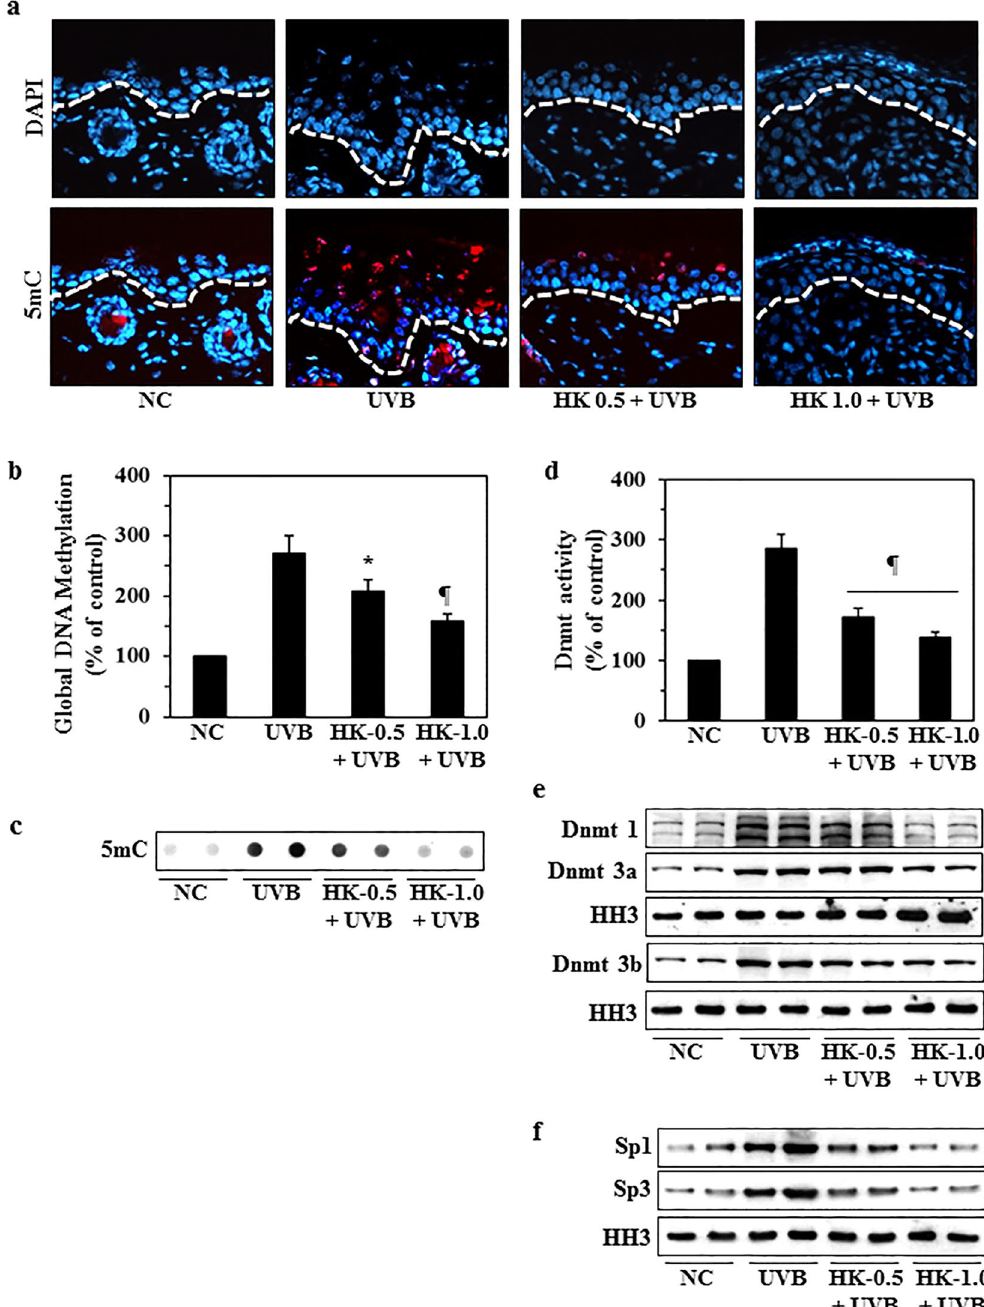
Figure 3. Topical application of honokiol inhibits UVB-induced DNA hypermethylation and DNA methyltransferase activity in UVB-irradiated mouse skin. Clipper-shaved mouse skin was exposed to UVB radiation (150 mJ/cm 2 ) for 4 consecutive days with and without topical application of honokiol. Mice were sacrificed 24 h after the last UVB exposure. Skin samples from each mouse were collected for analysis. ( a ) Representative micrographs of skin samples subjected to immunohistochemical detection of DNA methylation- positive (5mC + ) cells using a 5mC-specific antibody. 5mC + cells appear red. White line represent the boundary between epidermis and dermis. ( b ) Epidermal DNA was extracted and subjected to analysis of global DNA methylation using a Global DNA Methylation Kit. ( c ) The levels of 5-mC were estimated in DNA samples from different groups by dot-blot analysis. A representative dot-blot is shown. ( d ) Nuclear extracts were prepared and total Dnmt activity determined using the Dnmt Activity Assay Kit. Data are presented in terms of percentage versus non-UVB-exposed control skin samples. Significant inhibition versus the group exposed to UVB but not treated with honokiol, * P < 0.01, ¶ P < 0.001. ( e ) The skin samples from different treatment groups were also analyzed for the levels of Dnmt1, Dnmt3a and Dnmt3b proteins using western blot analysis. ( f ) The expression levels of the transcription factors, Sp1 and Sp3, were determined by western blotting. Equal nuclear protein loading on gels was verified using anti-histone H3 antibody